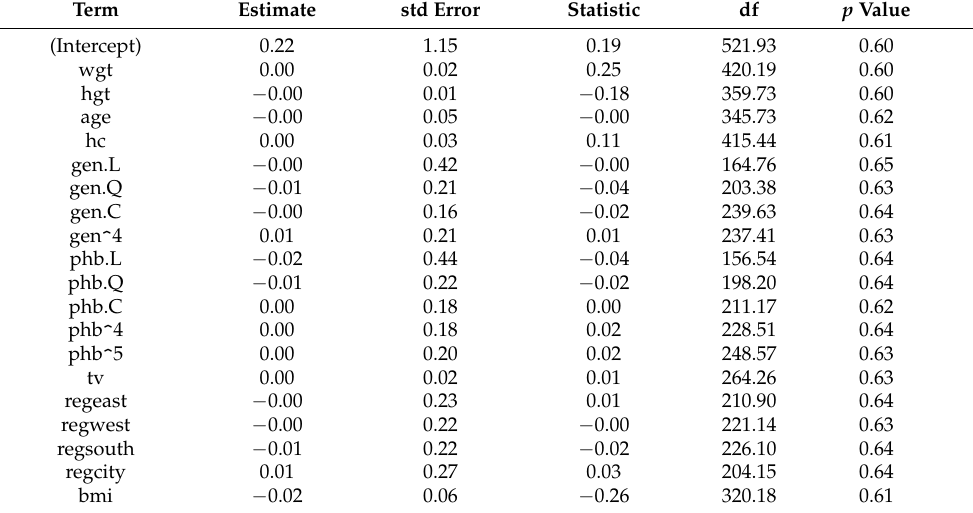
Table 6. Simulation results for a logistic regression model aimed at discriminating between synthetic records and true